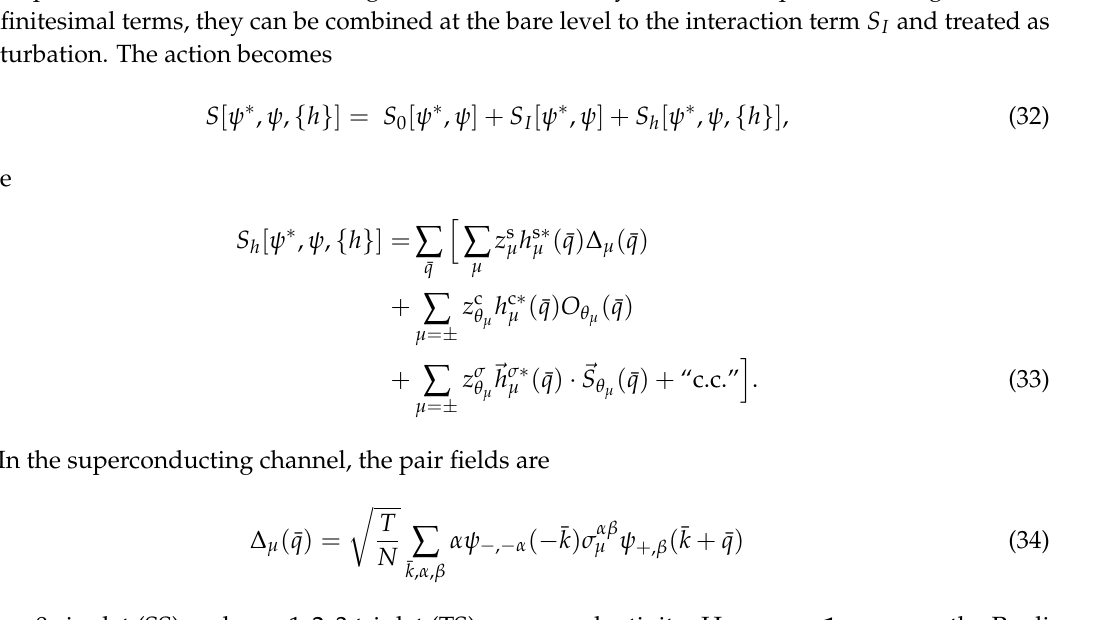
Figure 3. Contour plot of the normalized one-loop charge gap ∆ ρ /2 E F ( alternating site ( (cid:101) 0 ) and bond ( δ t ) potentials. The calculations are done for repulsive interactions U / t = V / t = 0.5 and δ U / t = δ V / t =